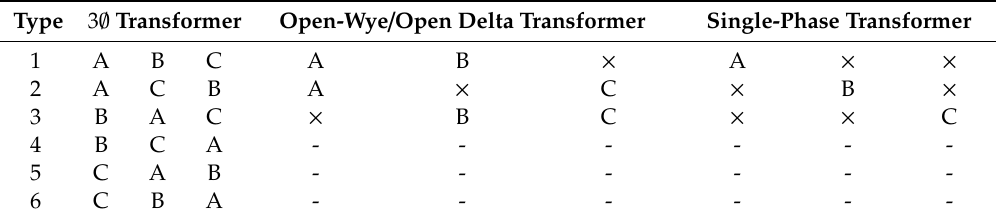
Table 1. The possible connection schemes of transformers.